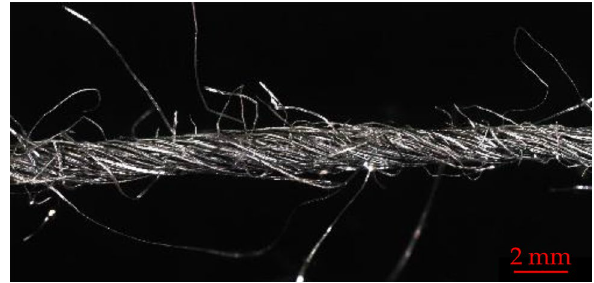
Fig. 12 Yarn irregularities CV twister at the flyer spinning process